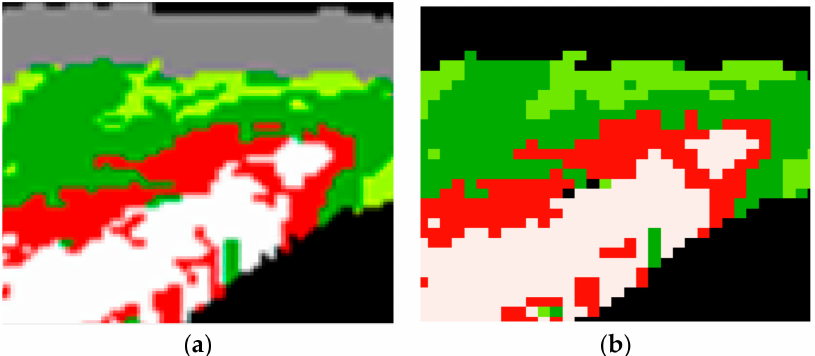
Figure 7. Segmentation by KMPSO-mED: ( a ) overlapped tissue, and ( b ) segmented